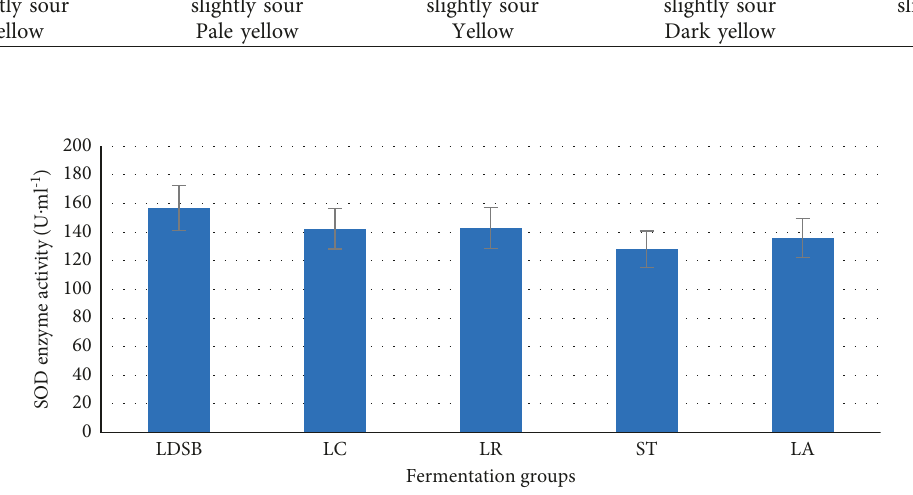
Figure 2: Effect of fermentation with different strains of bacteria on SOD enzyme activity force ( P